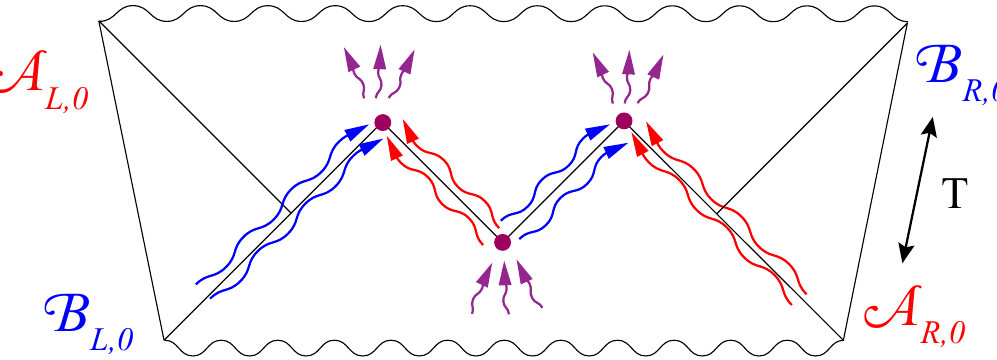
Figure 6 . A long wormhole supported by four shocks. The free product algebra A R, 0 ∗ B R, 0 describes shocks created at the right boundary, while the commutant algebra A L, 0 ∗ B L, 0 describes shocks at the left boundary. The collisions between shocks (purple) are transplanckian and so cannot be described by semiclassical